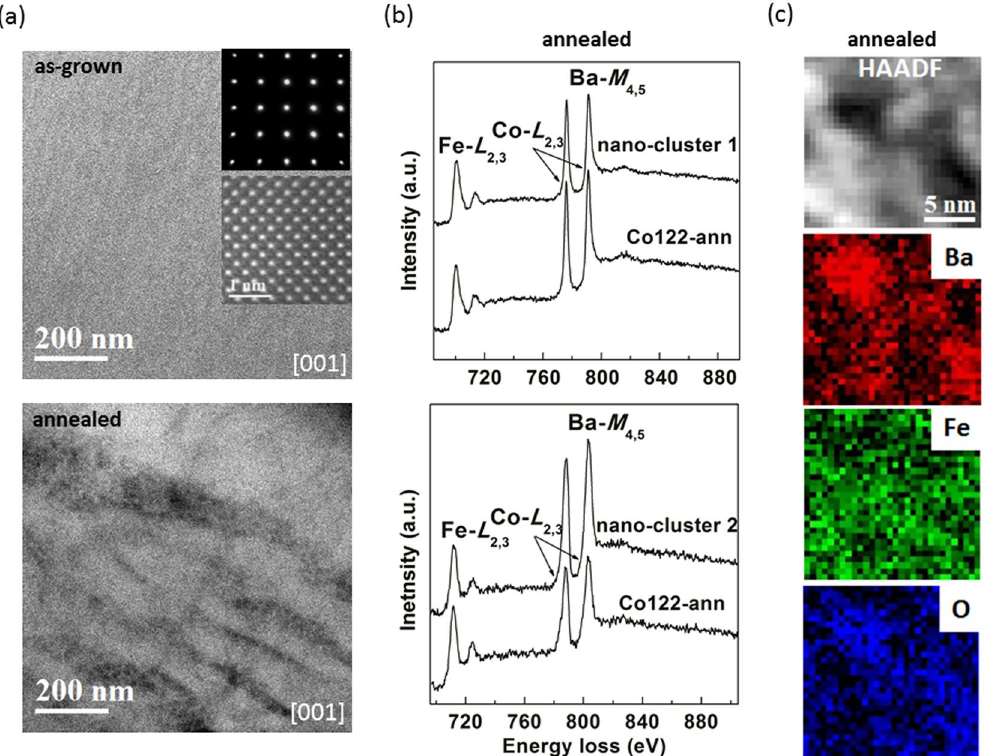
Figure 8. Evidence of chemical clustering in annealed optimally-doped Ba(Fe 1 − x Co x ) 2 As 2 crystal: ( a ) Typical STEM HAADF images along [001] showing chemical homogeneity for as-grown (top) versus nano-clusters in annealed (bottom) crystals, the insets are typical electron diffraction patterns and atomic resolution image. For annealed crystals, two different types of nano-clusters showing chemical inhomogeneity as revealed by ( b ) EEL spectra and ( c ) EELS mapping for one type of